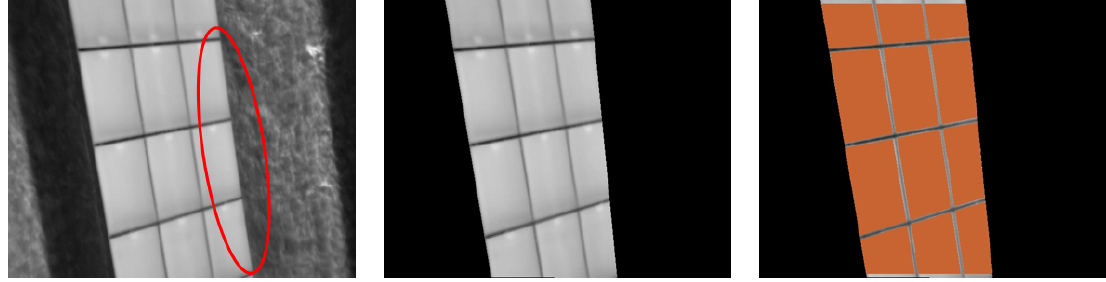
Figure 15. Not adequate segmentation of the panels surface.